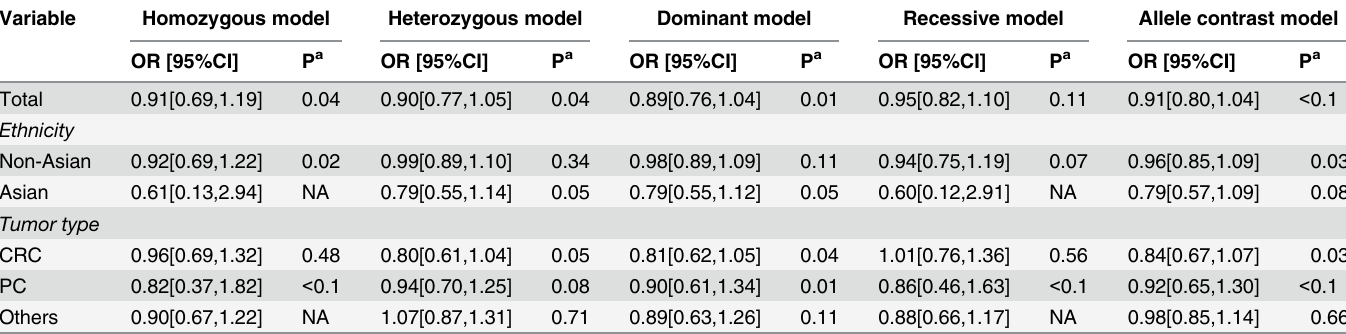
Table 2. Overall and subgroup analysis of the ADIPOR1 rs12733285(C/T) polymorphism and cancer risk.